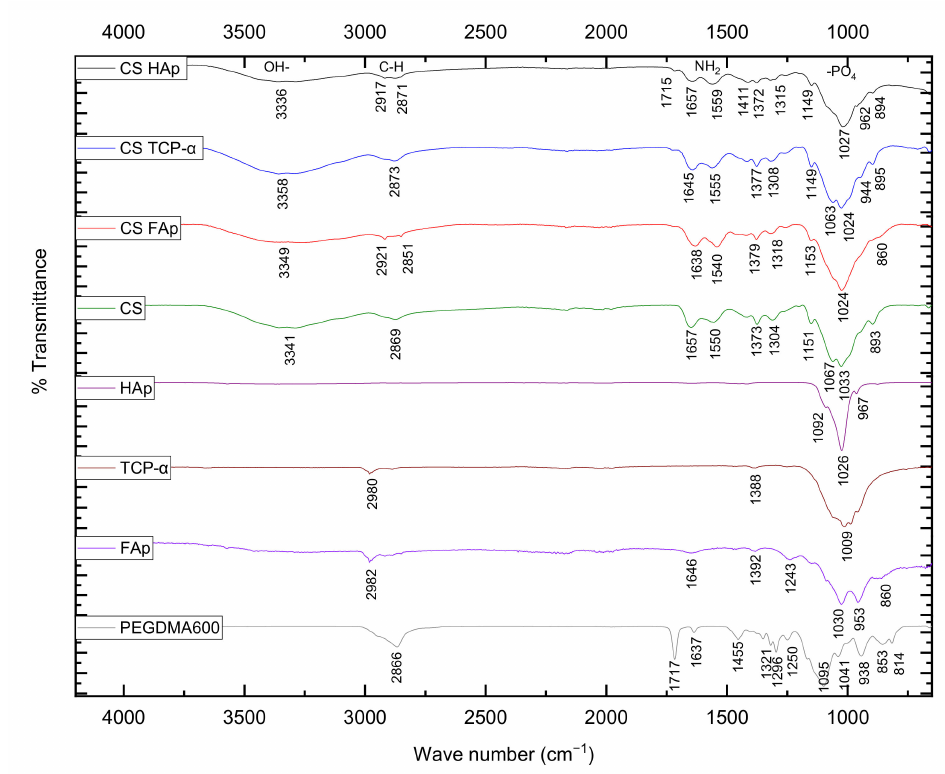
Figure 3. FTIR spectrum of individual components and different CS/ceramic scaffolds following the crosslinking